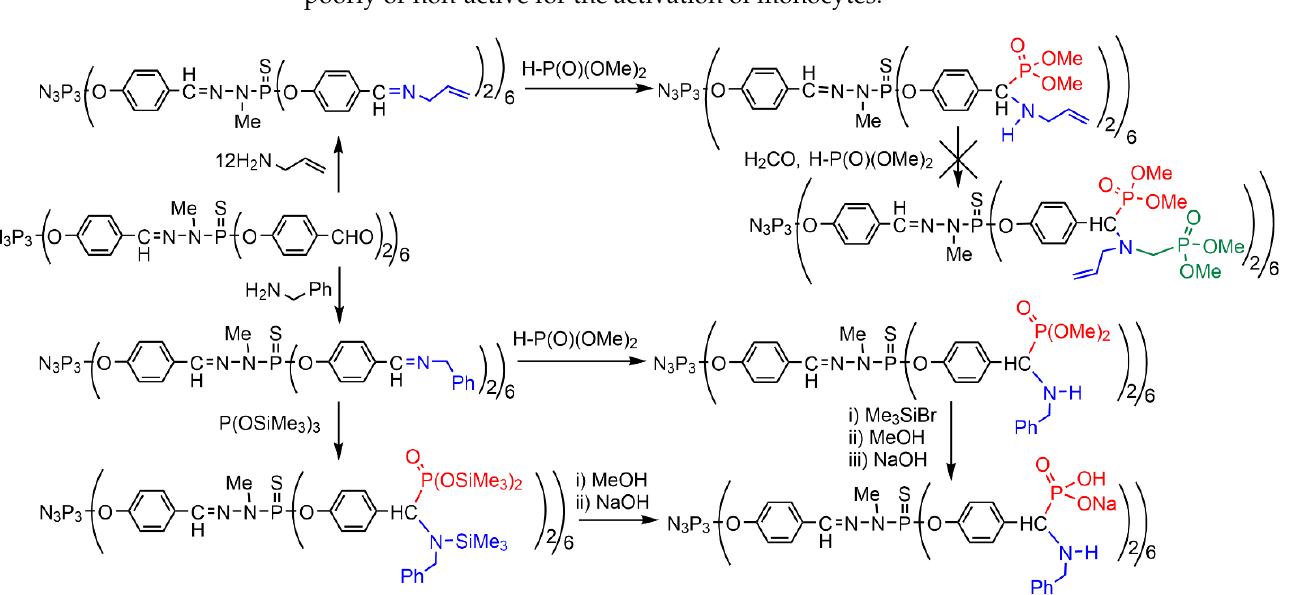
Figure 8. Dendrimers linked to SiO 2 NPs and hosting Ag/Ag 2 O NPs exhibiting antibacterial activity.